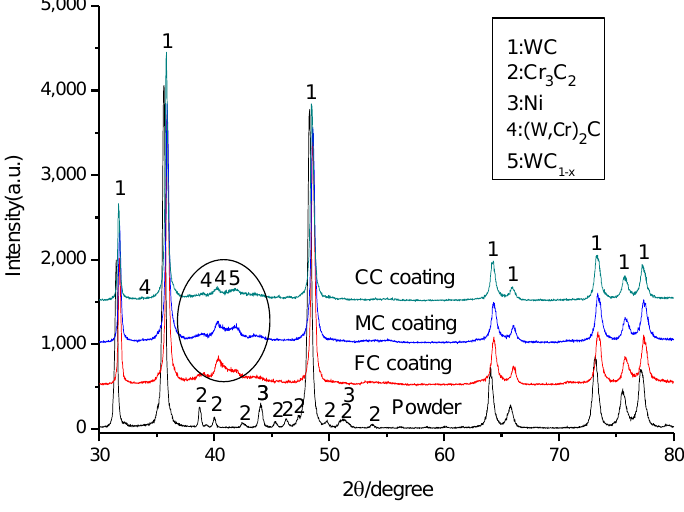
Figure 5. XRD patterns of the WC-20Cr 3 C 2 -7Ni powder and coatings.